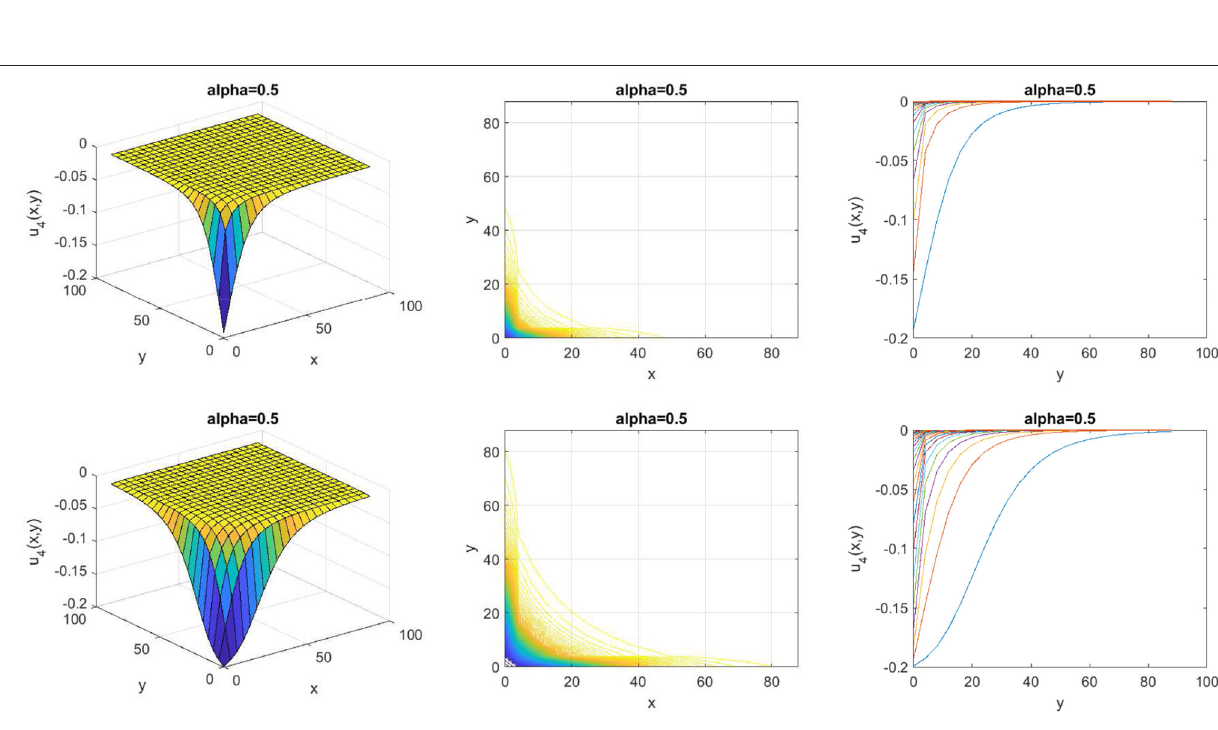
FIGURE 4 | Kink wave solution of Equation (37) in 3D, contour, and 2D for Case